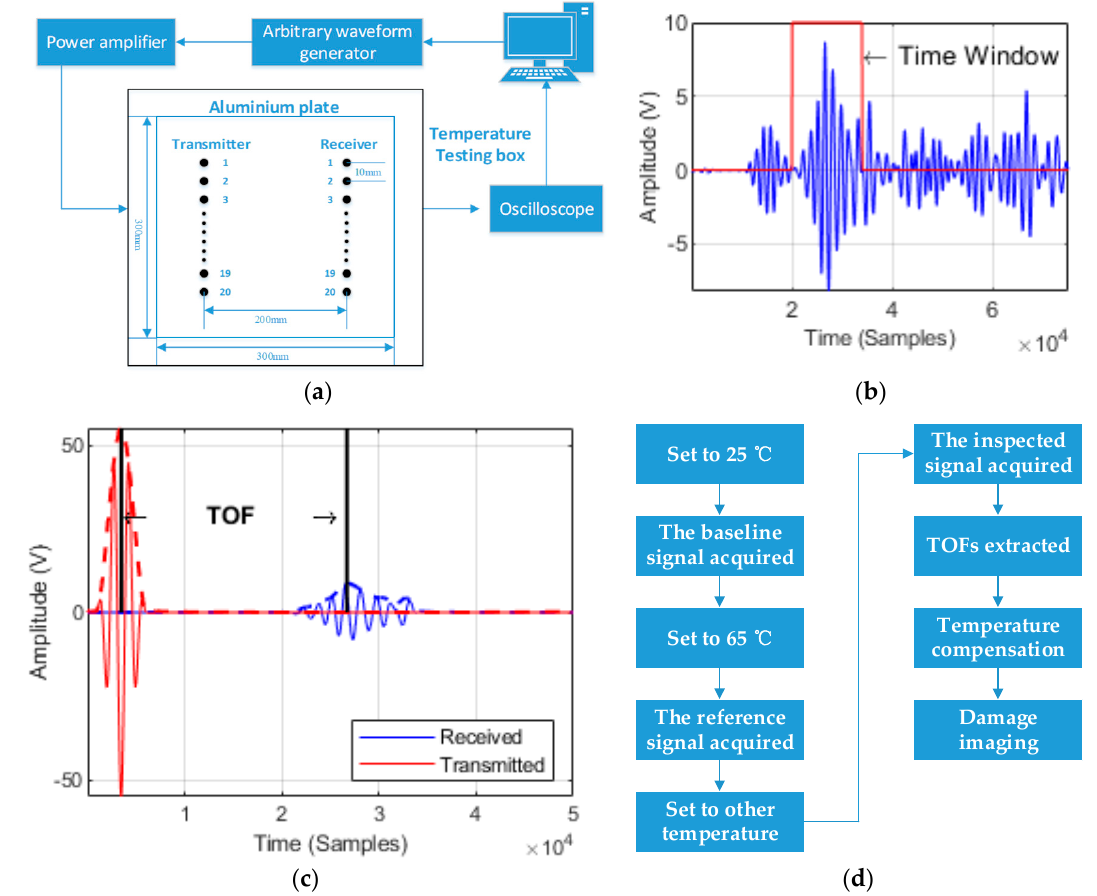
Figure 2. ( a ) SHM system diagram. ( b ) A typical time trace from the experiment within the chosen time window. ( c ) An example of TOF extraction from the transmitter and the receiver. ( d ) A flowchart of the experiment.